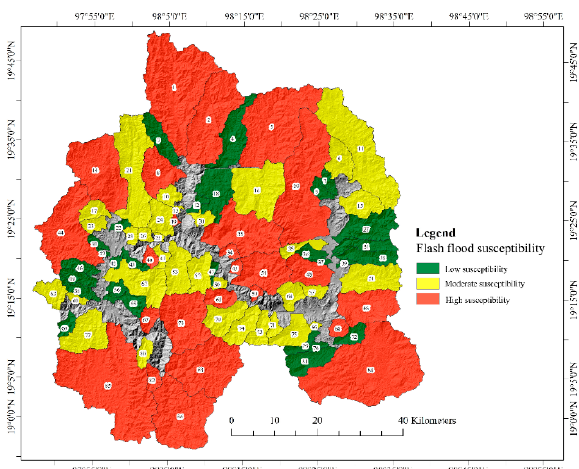
Figure 16. Flash flood susceptibility map of Pai River Basin, Mae Hong Son, Thailand.